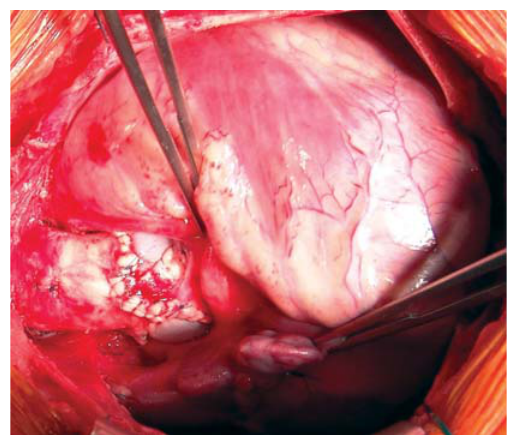
Fig.4 – Aorta ascendente ampliada e reconstruída com placas de pericárdio